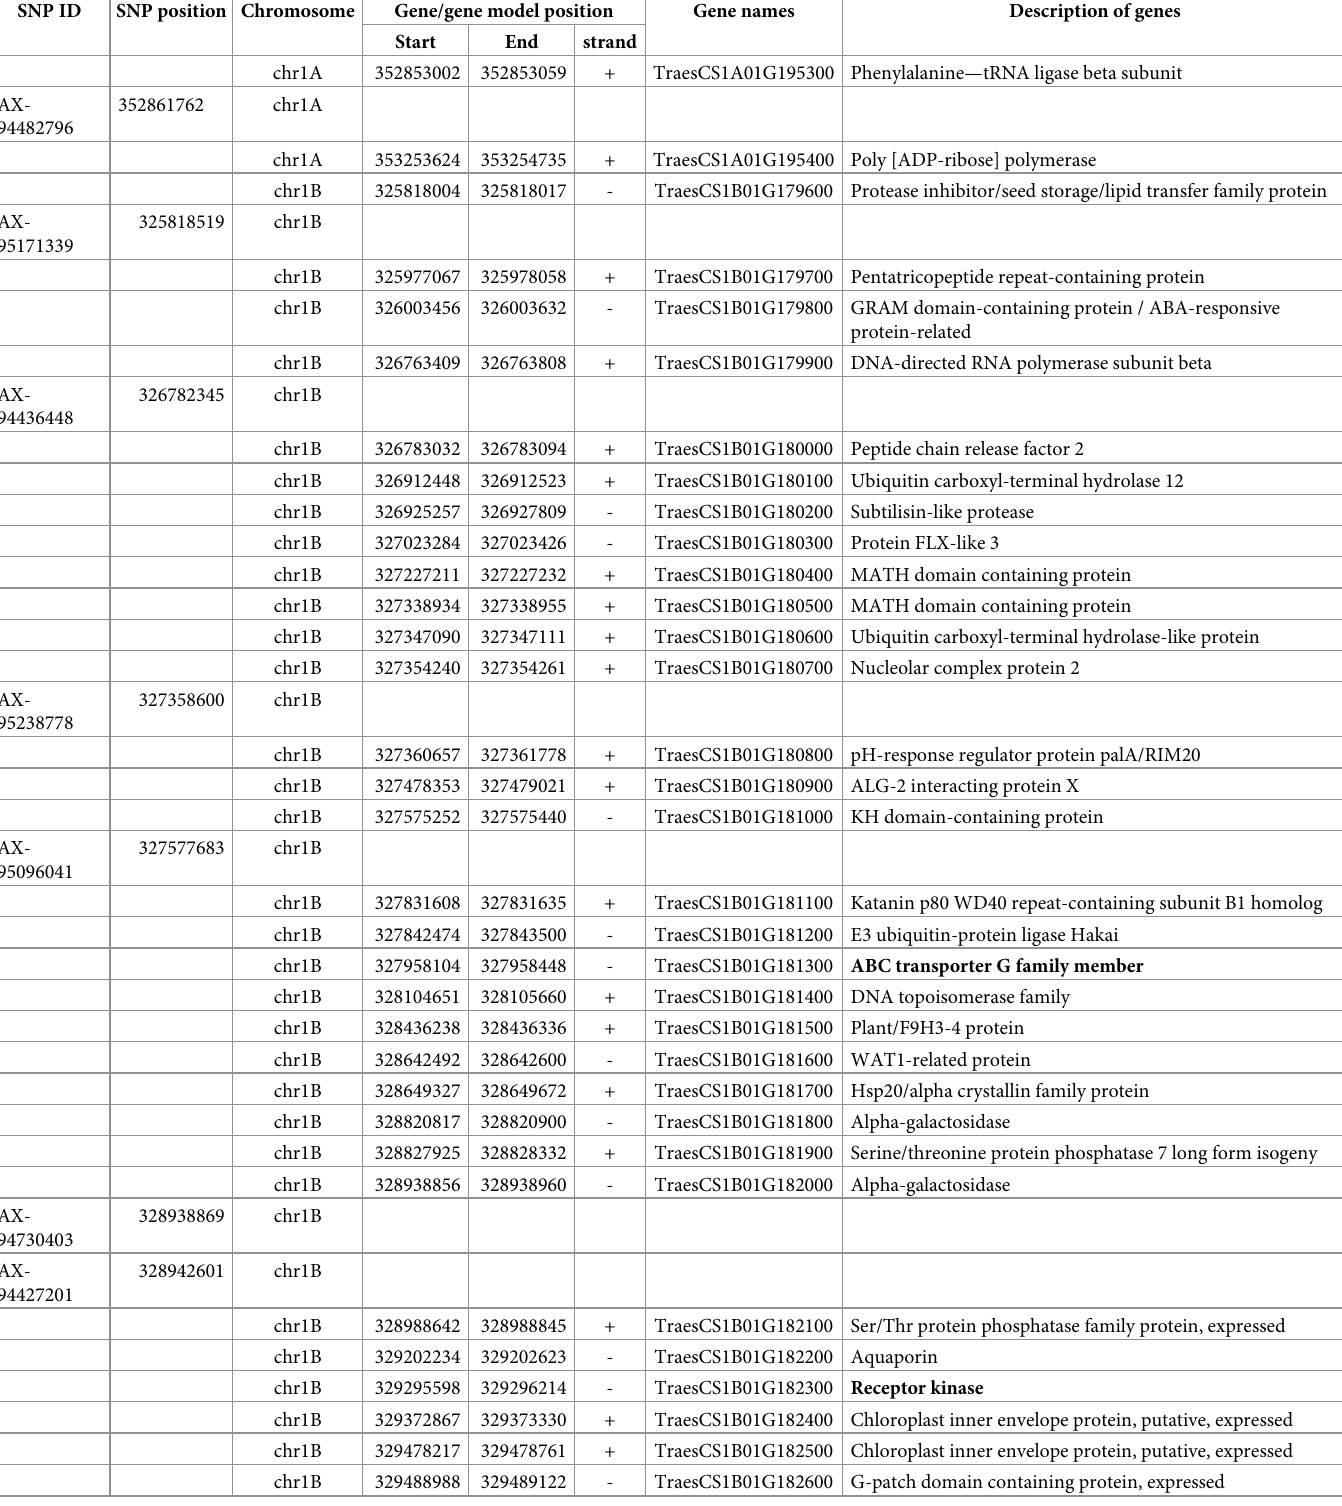
Table 8. Genes and gene models a reported with in the identified Yr resistance associated regions and close to the significant